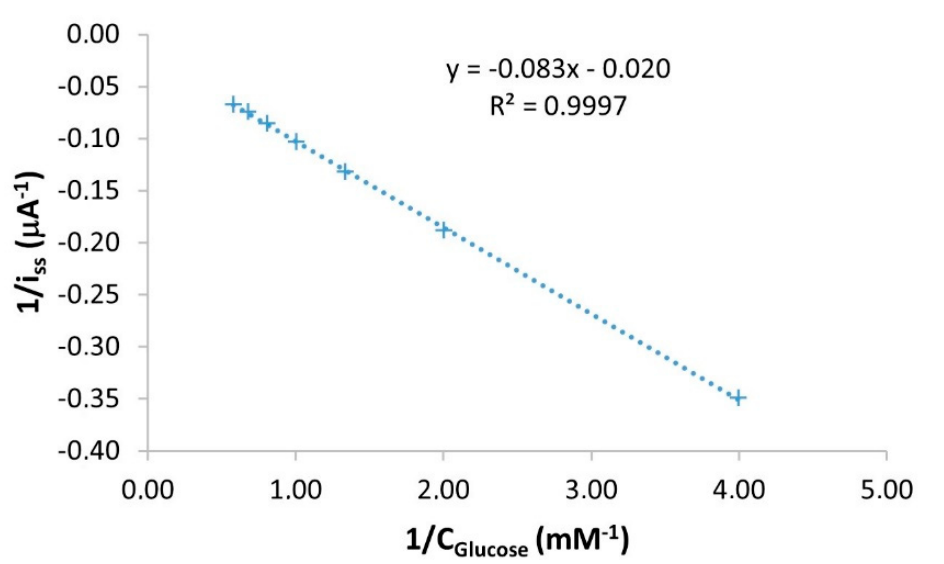
Figure 3. Representation of the Lineweaver-Burk equation using the data obtained from the calibra- tion curve acquired using a Ti/TiO 2 NTAs/ppHEMA-co-EGDA/pgPFM/GOx/Chitosan biosensor. Table 2. Values of the apparent Michaelis–Menten constant of different glucose biosensors described in the literature and of the Ti/TiO 2 NTAs/ppHEMA-co-EGDA/pgPFM/GOx/Chitosan biosensor developed in the present work. The value shown in the present work is the average value and its deviation obtained from three different